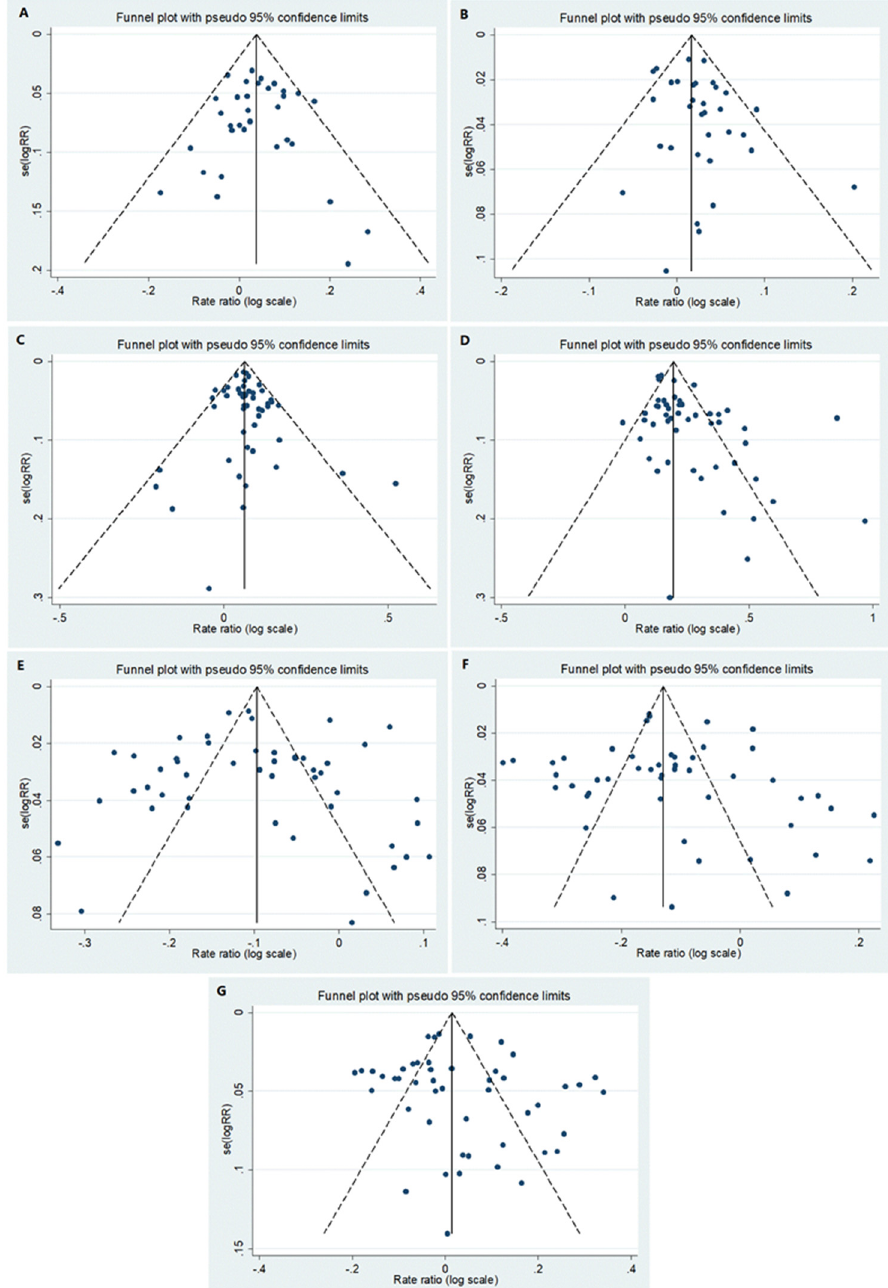
Figure 1. Funnel plots for the following age groups: ( A ) <1, ( B ) 1–4, ( C ) 5–9, ( D ) 10–14, ( E ) 15–39/15–44, ( F ) 40–59/45–64 and ( G ) 60+/65+.